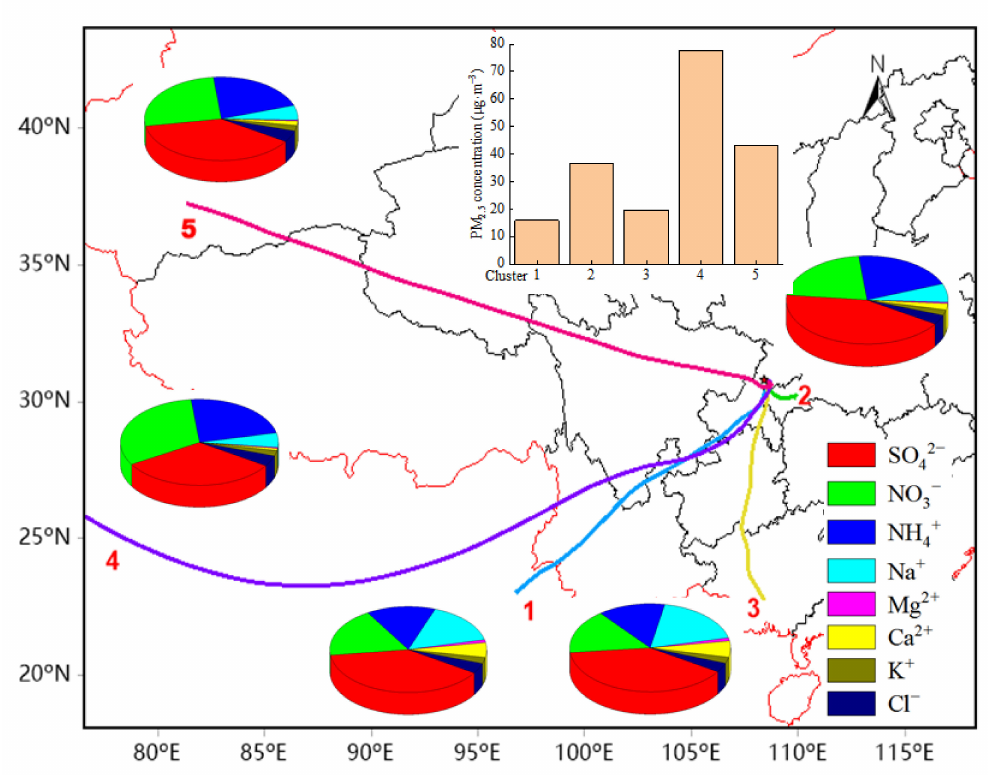
Figure 6. 72 h backward trajectories clusters in Wanzhou during the observation